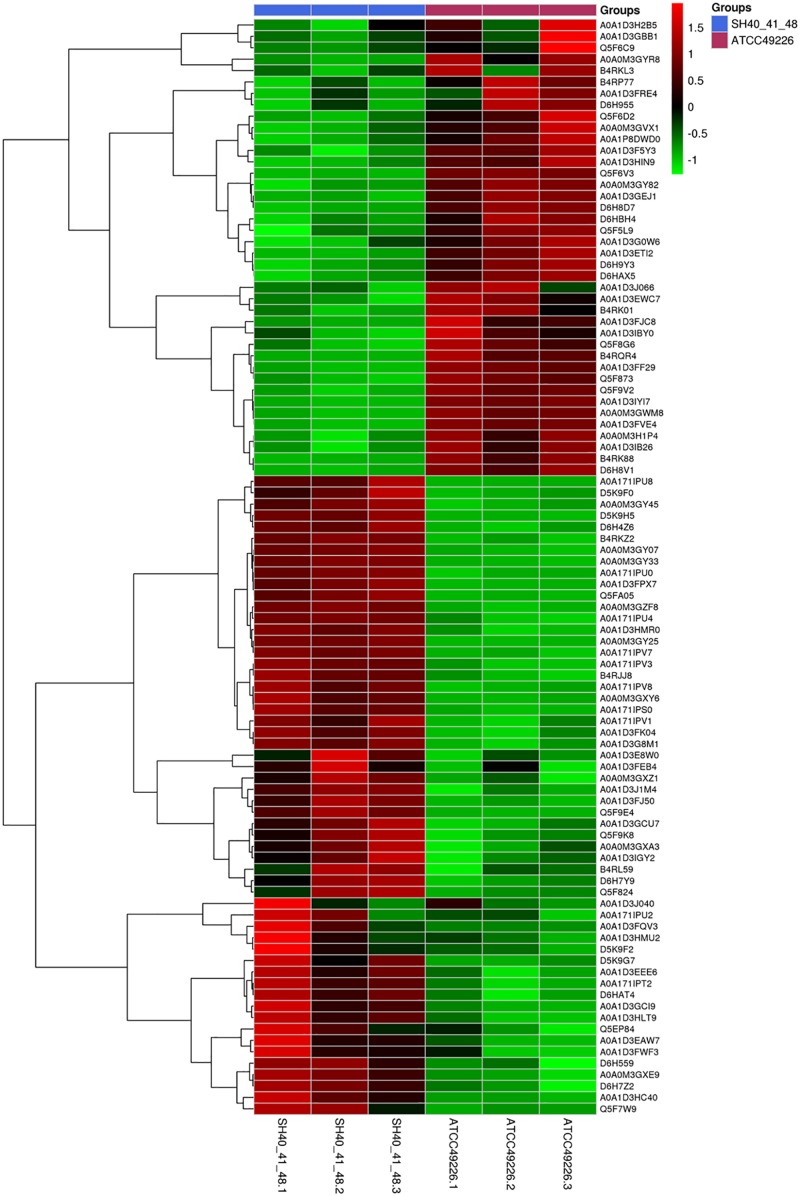
Heirarchical clustering analysis of 96 differentially expressed proteins in N. gonorrhoeae isolates. Red and green squares indicate higher and lower abundances compared with the average expression, respectively.